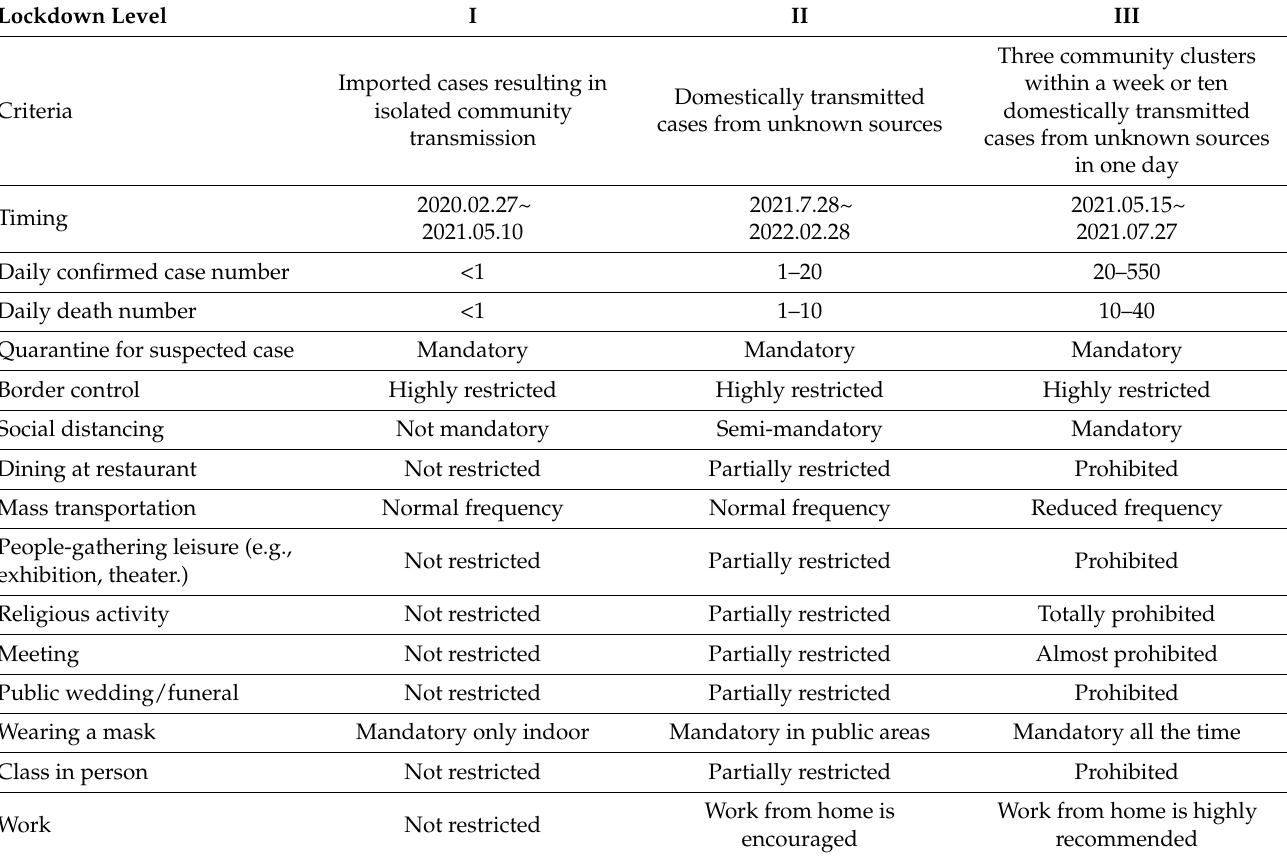
Table 1. Lockdown policy of the Taiwan government for